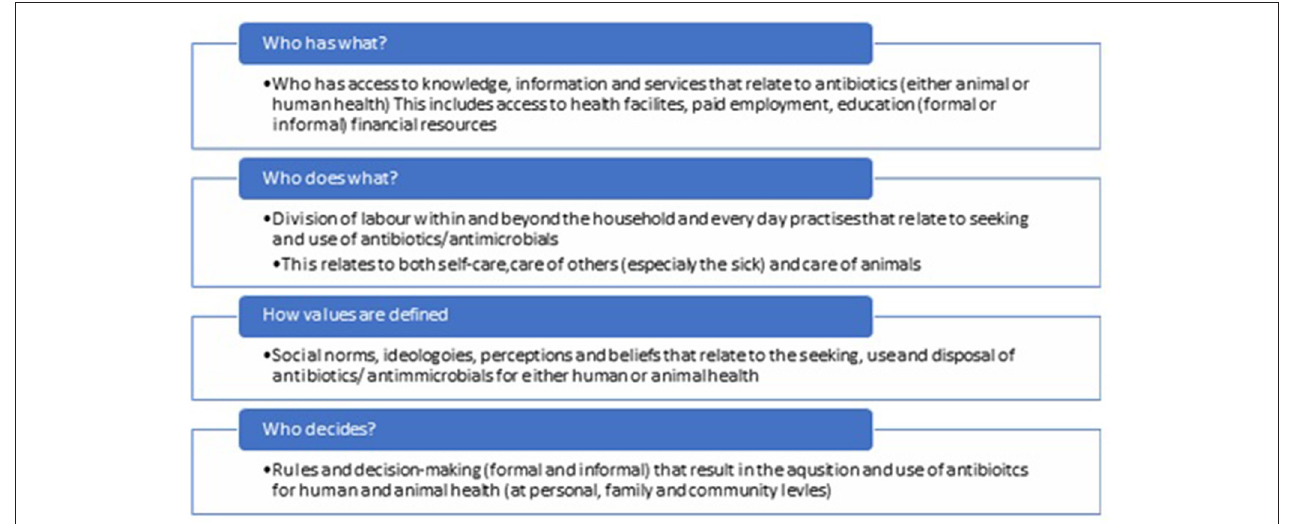
FIGURE 1 | Final analysis